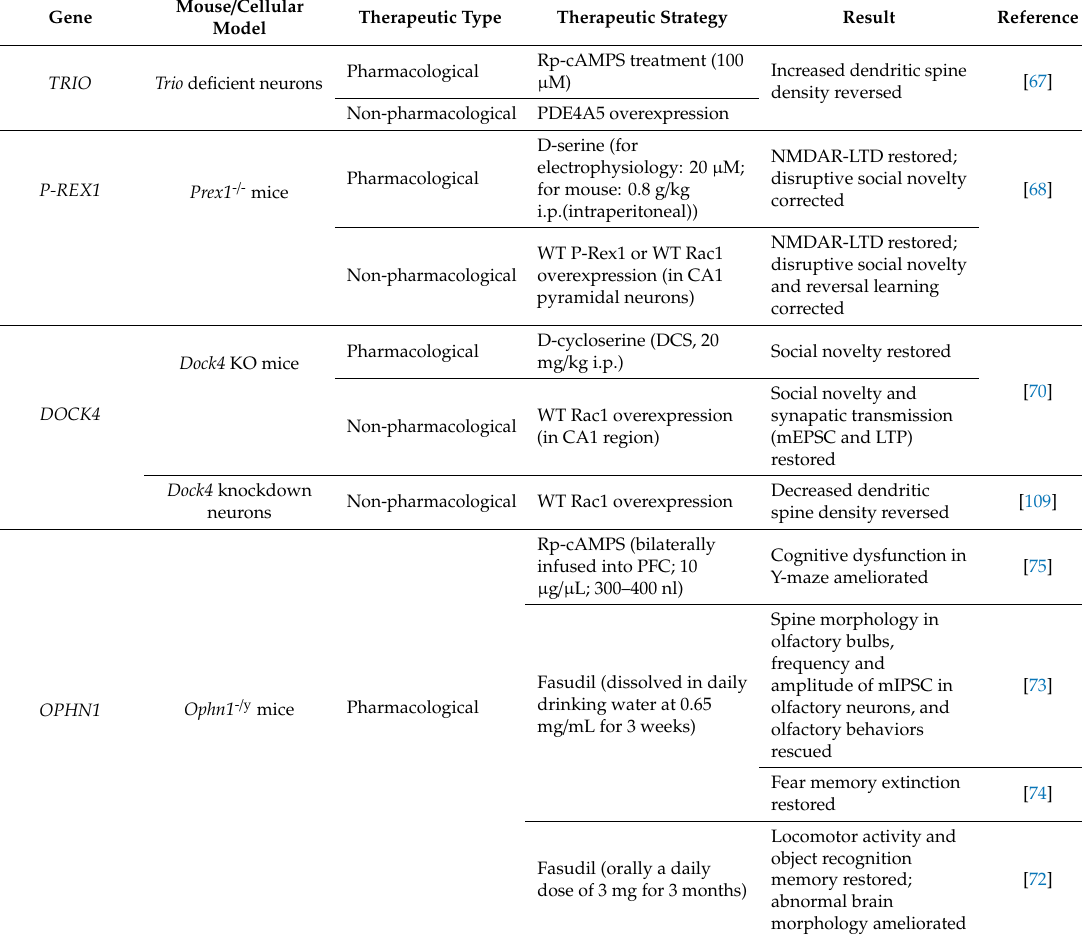
Table 3. Treatments for Rho GTPase mouse